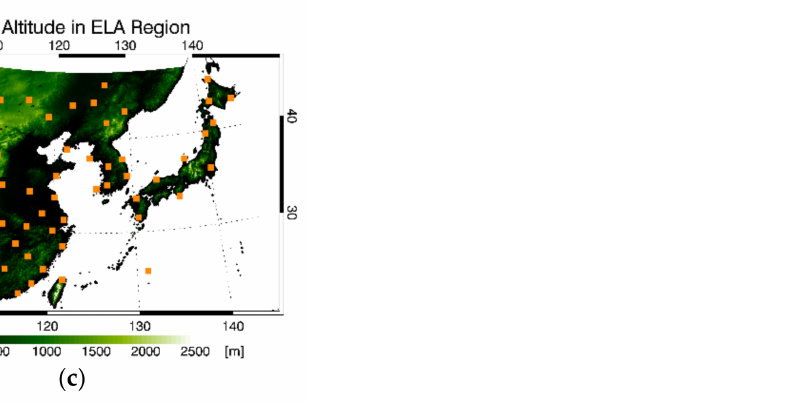
Figure 1. The study area (extended local area; ELA) with ( a ) averaged TPW using ECMWF model reanalysis (ERA5) for one year in 2020, and ( b ) averaged CAPE using ERA5 during summer in 2020, and ( c ) altitude plotted with radiosonde observation stations (orange dots).